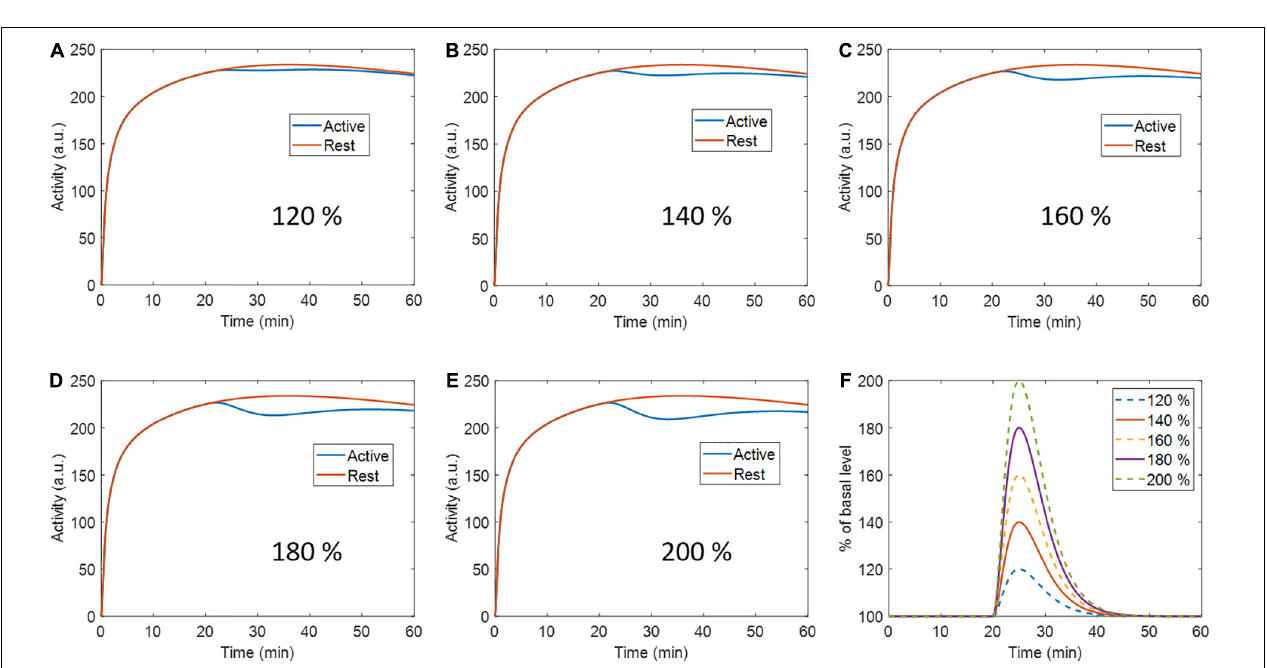
FIGURE 1 | 2D phantom regions and time activity curves used to generate the dynamic events data in the respective regions.